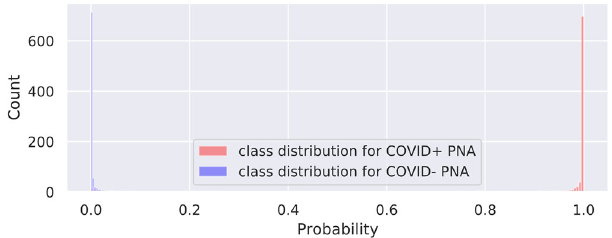
Fig. 7 Two-dimensional manifold of features generated using t-distributed stochastic neighbor embedding (TSNE) on the DCD model. DCD evaluated on the test set of China-1 (80% of China-1). It was trained on sites 1 to 11 and fi netuned on the training set of China-1 (20% of